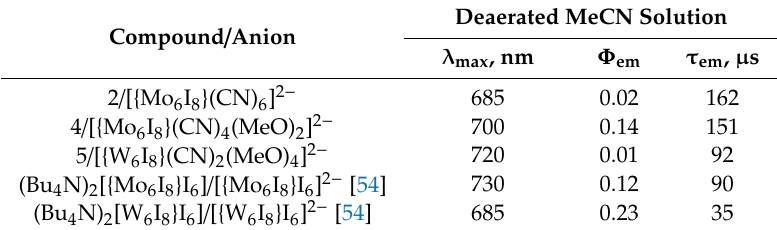
Table 3. Spectroscopic and photophysical parameters of compounds 2 , 4 and 5 in deaerated acetonitrile solutions ( λ ex = 360 nm) in comparison with those reported for (Bu 4 N) 2 [{Mo 6 I 8 }I 6 ] and (Bu 4 N) 2 [{W 6 I 8 }I 6 ].